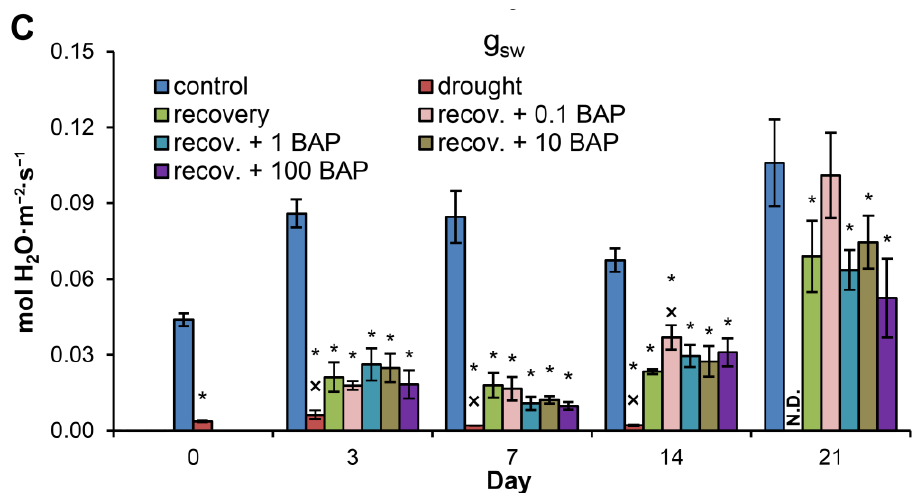
Figure 4. The influence of water deficit, recovery and 6-BAP spraying on the leaf water potential ( A ), RWC ( B ) and stomatal conductance ( C ) of pine plants during Experiment 2. In the first set of pairwise comparisons of the means, all variants were compared with “control” plants at each separate time point using Student’s t- test or Mann–Whitney rank sum test. Asterisks (*) denote significant differences at p < 0.05 between the control and experimental variants at each time point. In the second set of pairwise comparisons of the means, all variants were compared with “recovery” plants at each separate time point using Student’s t- test or Mann–Whitney rank sum test. Multiplication signs ( × ) denote significant differences at p < 0.05 between the “recovery” variant and the other experimental variants at each time point. N.D.—plants are dead, and, therefore, no data are present. Midday g sw dropped to 8.7% of the control level by Day 0 (Figure 4C). In the